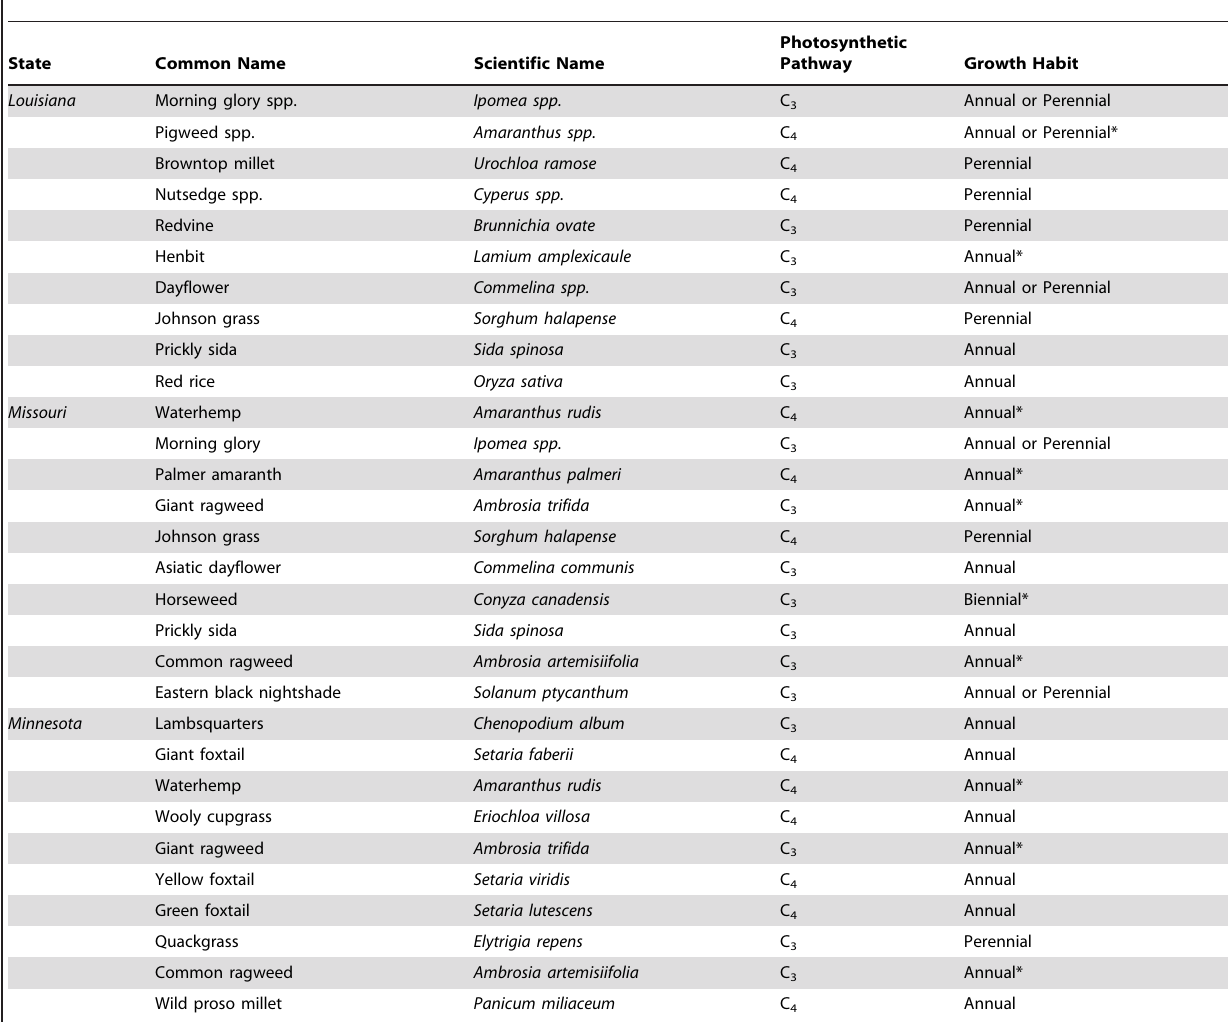
Table 2. Top ten lists of most troublesome weed species in soybean for three states along the North-South transect.